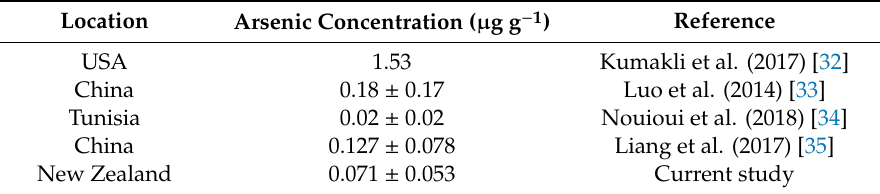
Table 2. Published average concentrations of